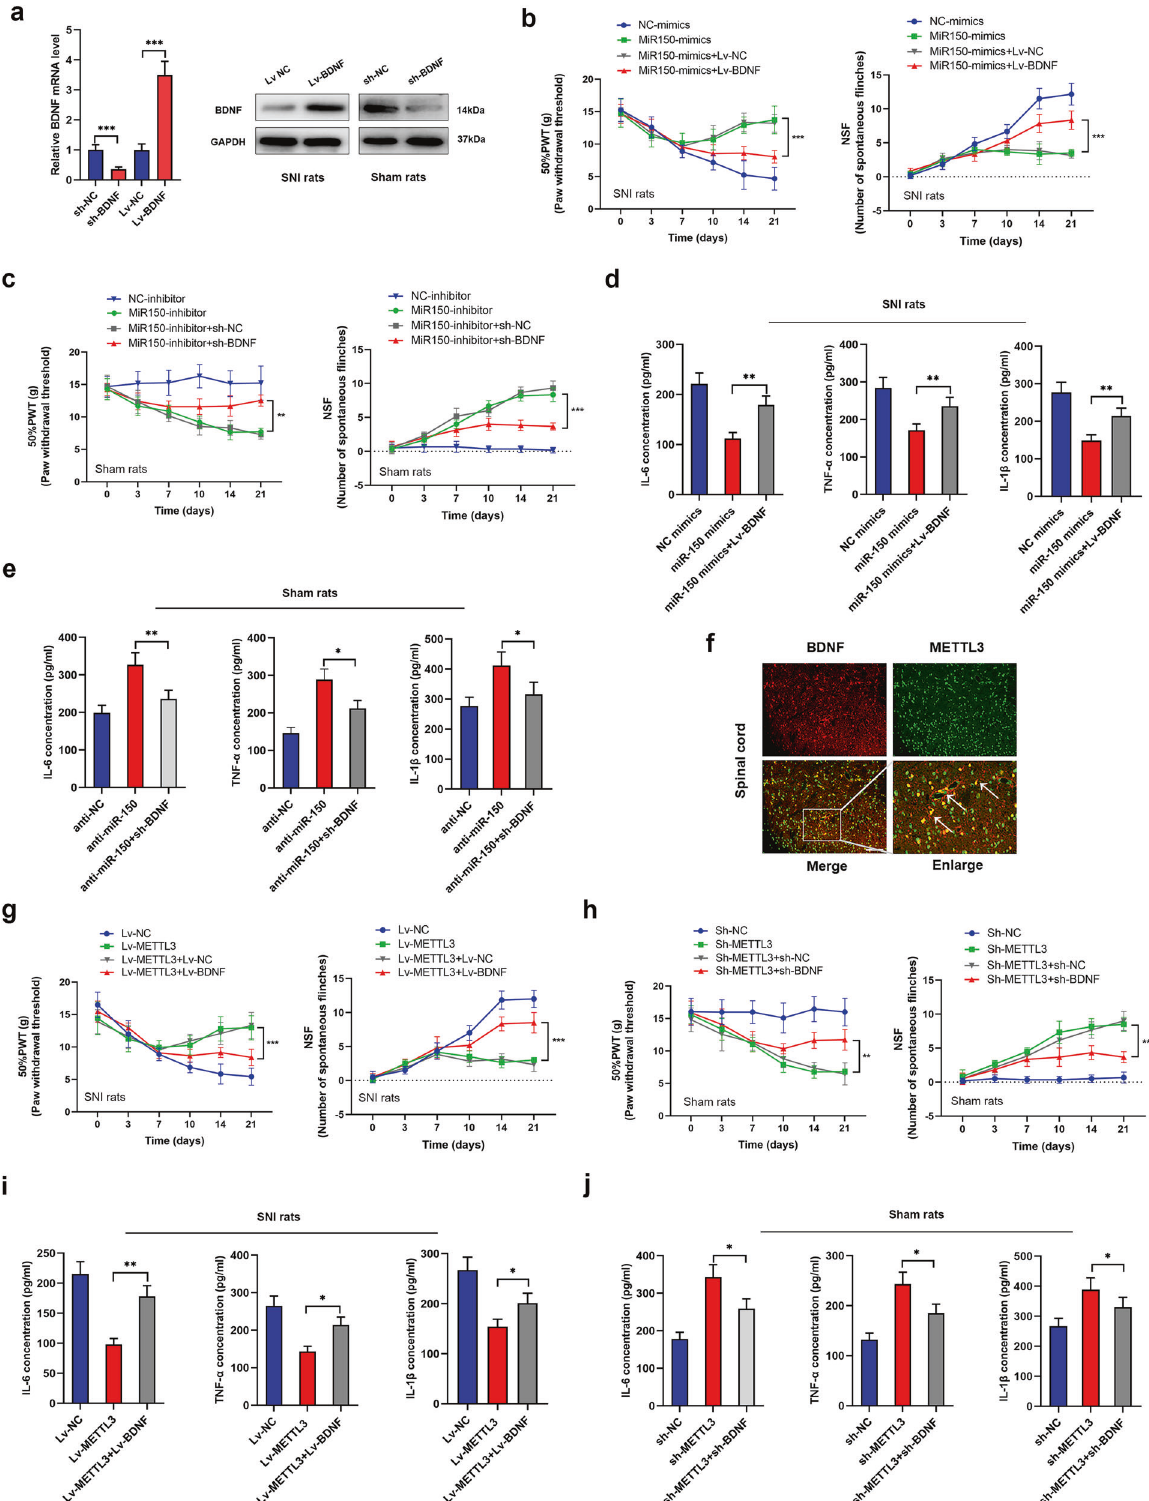
progression, if yes, the precise regulatory mechanism is not well de fi ned. In this study, we focused on METTL3, one important member of so-called m6A writers, and revealed that METTL3 was signi fi cantly downregulated in SNI-NP rats and NP